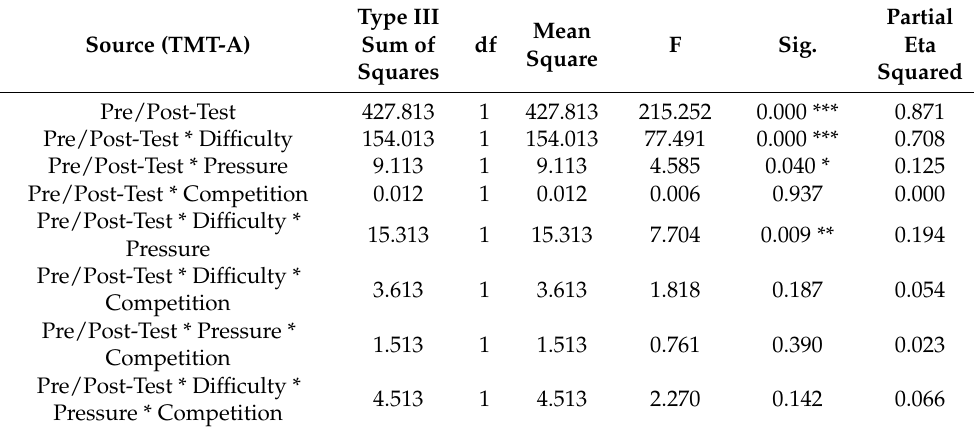
Table 16. Tests of within-subject effects of TMT-A.